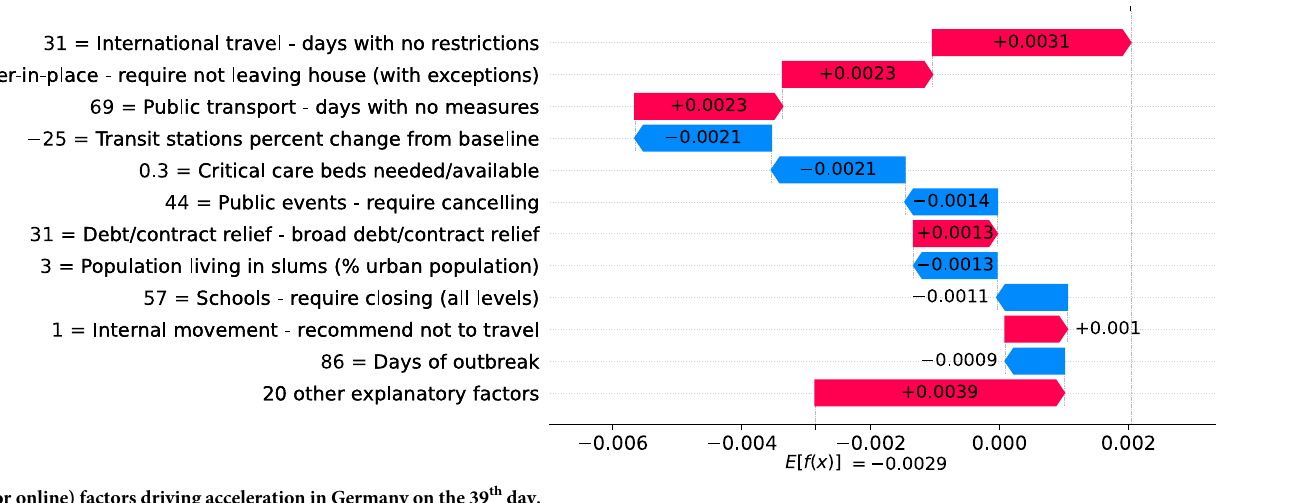
Fig 25. (Color online) factors driving acceleration in Germany on the 39 th day.